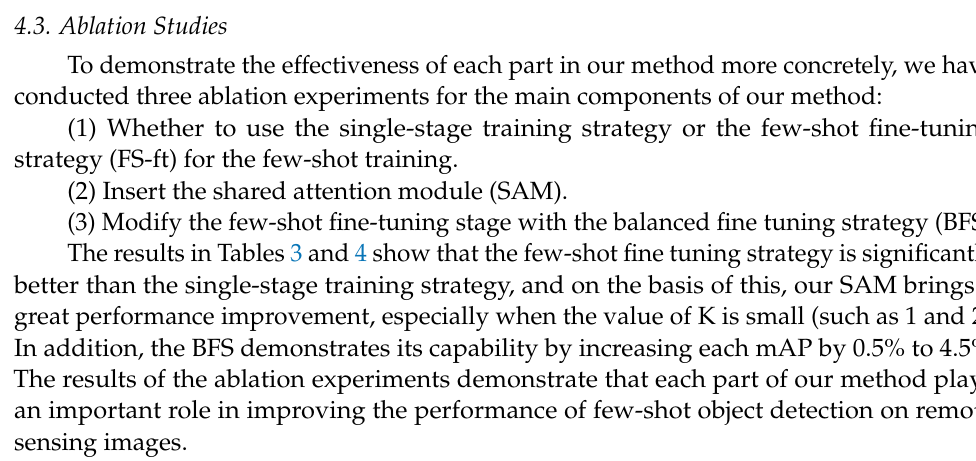
Figure 14. Results of our 10-shot model on novel classes in the NWPU VHR-10